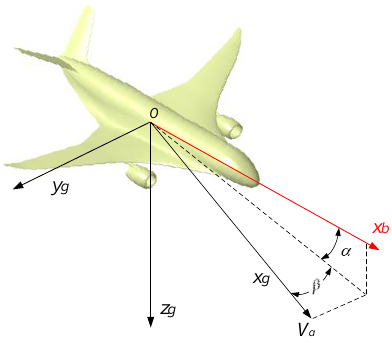
Figure 5. Ground coordinate system.